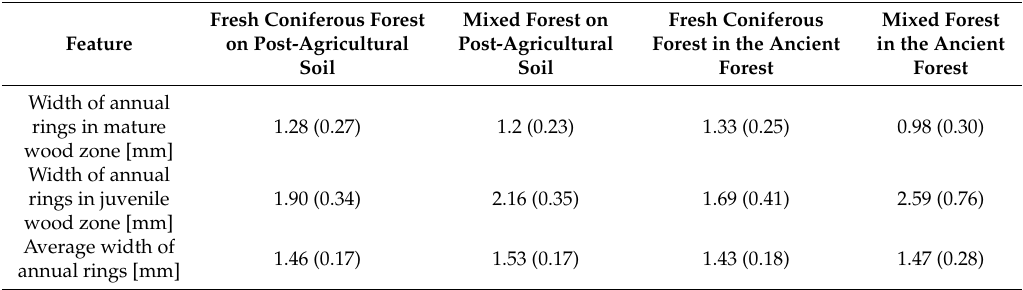
Table 4. Width of the annual rings in pine trunks from four experimental plots in the Chojn ó w Forest District (standard deviation is given in parentheses).